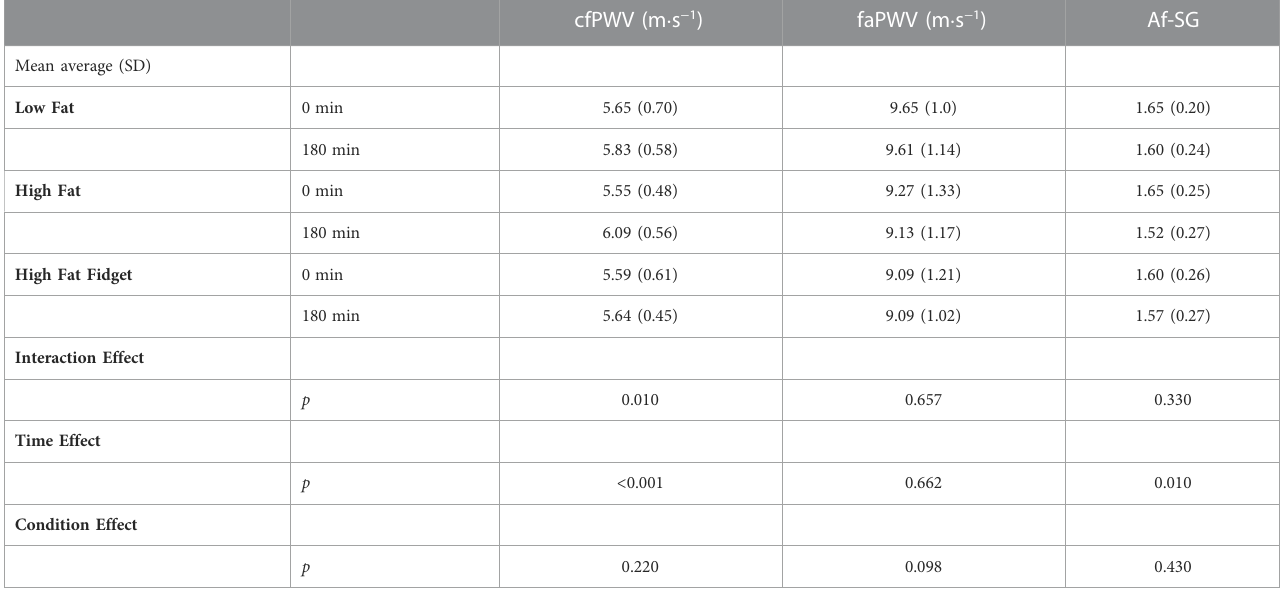
TABLE 1Mean (±SD)interactionand maineffects for central andperipheral pulsewave velocity, andthe aortic-femoralstiffness gradient pre andpostlowfat, high fat and high fat fi dgeting sitting trials ( n = 18).